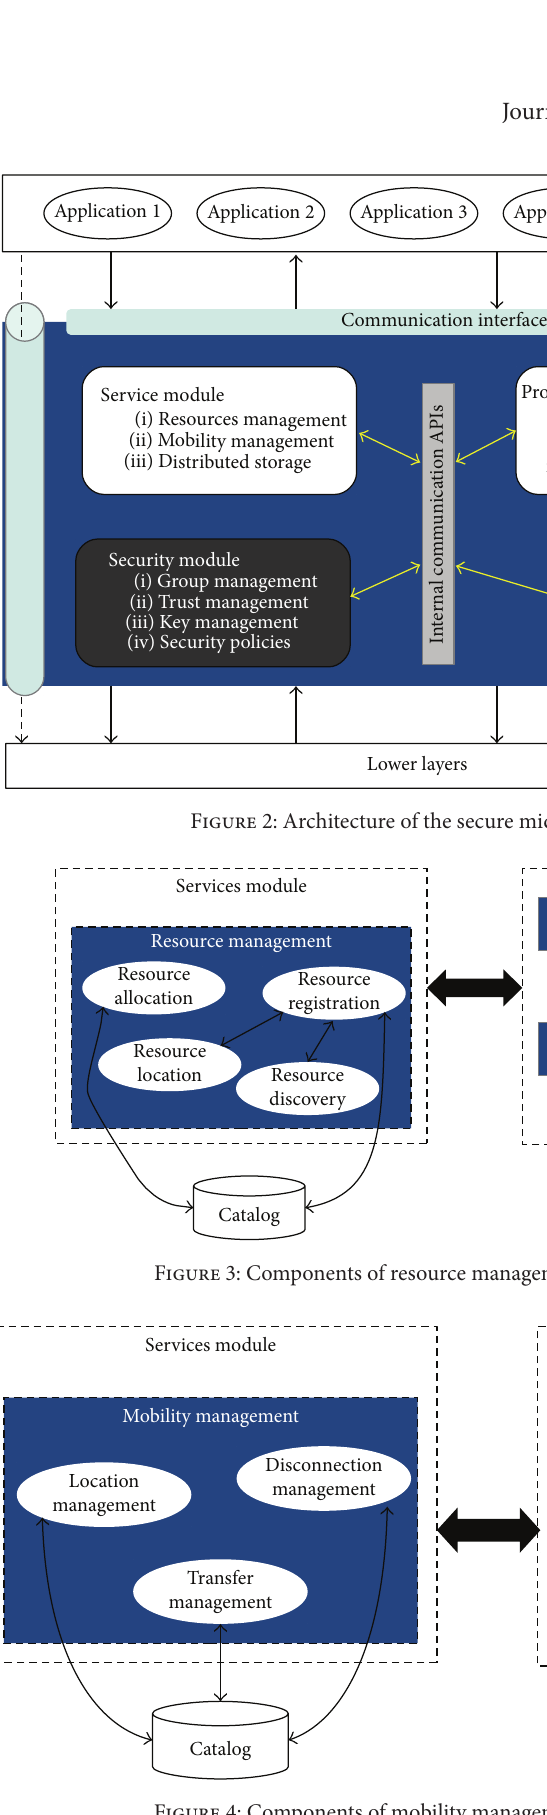
Figure 4: Components of mobility management